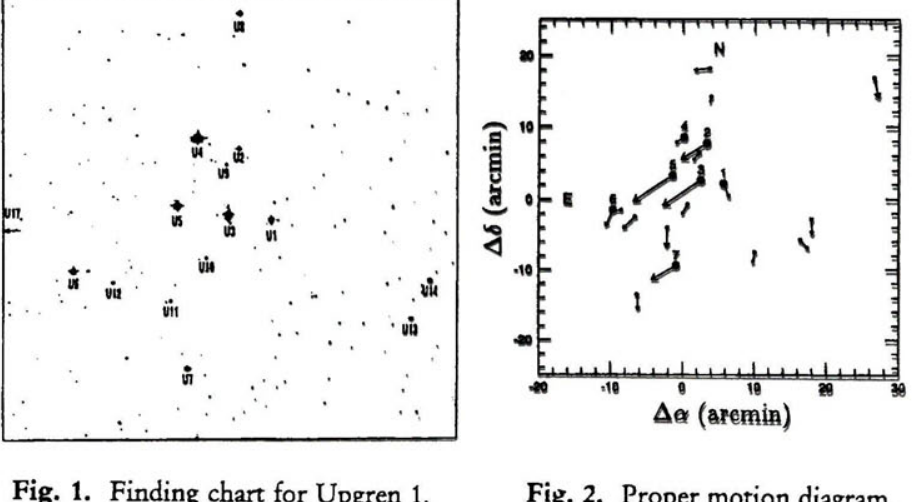
Fig. 1. Finding chart for Upgren 1. Fig. 2. Proper motion diagram